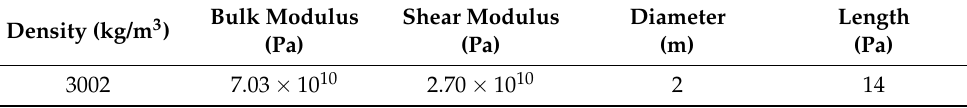
Table 3. Parameters of the